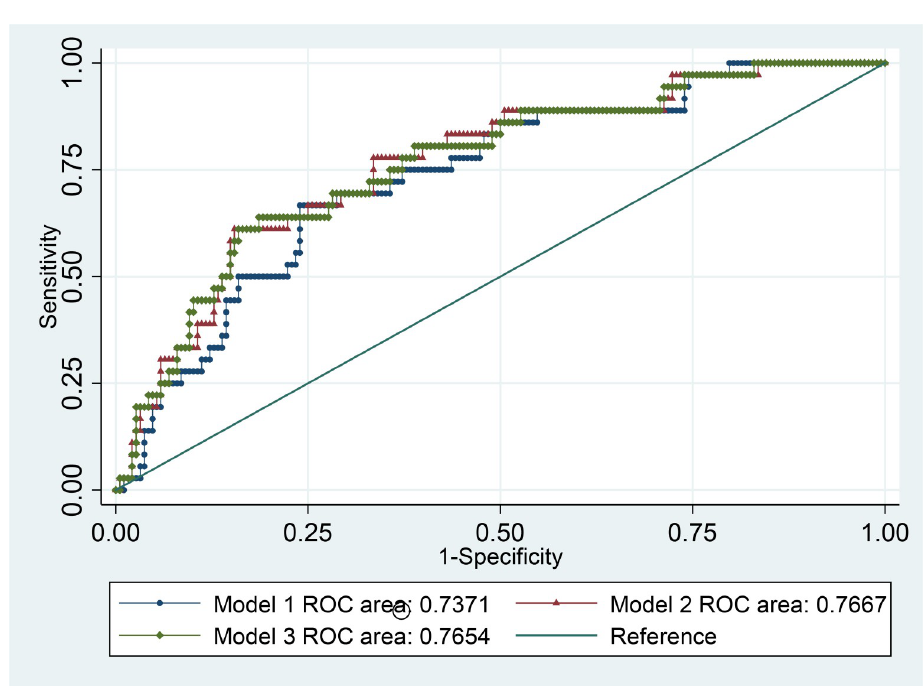
Fig 2. ROC analysis for multivariate models predicting